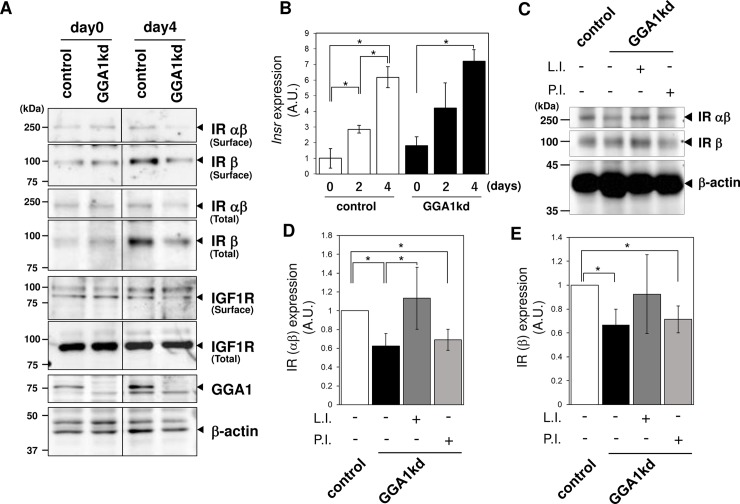
Gga1 knockdown impaired the expression of the insulin receptor.(A) Total proteins (Total) and the cell surface proteins (Surface) purified using surface biotinylation from growing (day 0) and differentiated (day 4) cells were subjected to immunoblotting for golgi associated, gamma adaptin ear containing, ARF binding protein 1 (GGA1), the insulin receptor (IR), and the insulin-like growth factor 1 receptor (IGF1R). b-actin was used as the loading control. (B) Quantitative real-time PCR (qPCR) for Insr (encoding IR) was carried out. (C) Lysosomal inhibitors suppressed the degradation of the IR in Gga1kd cells. Myotubes differentiated for 4 days were treated with lysosomal inhibitors (L.I.) or proteasome inhibitor (P.I.) for 18 hours. The total lysates were subjected to immunoblotting for the IR. The signals for the ab precursor (D) and b-chain (E) of the IR were quantified and normalized by the b-actin signal. Error bars indicate the SD (n = 3). *. P < 0.05 by Welch’s t-test.